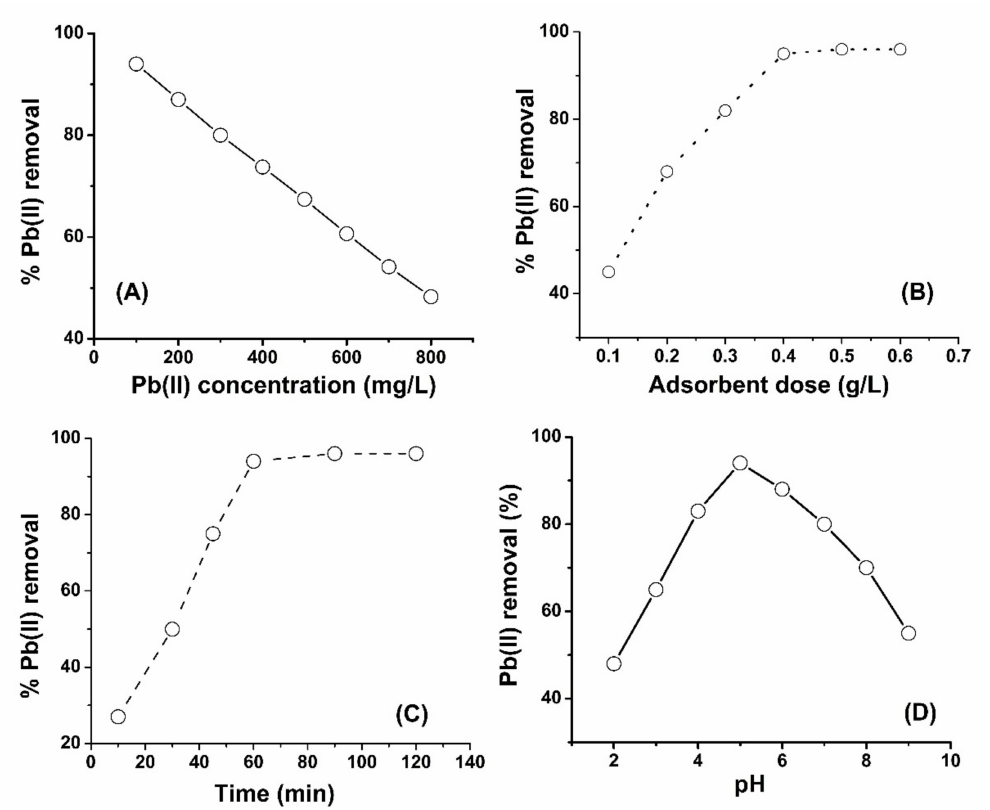
Figure 3. Effect of concentration ( A ), adsorbent dose ( B ), contact time ( C ) and pH ( D ) on Pb(II) adsorption onto chemically modified silica